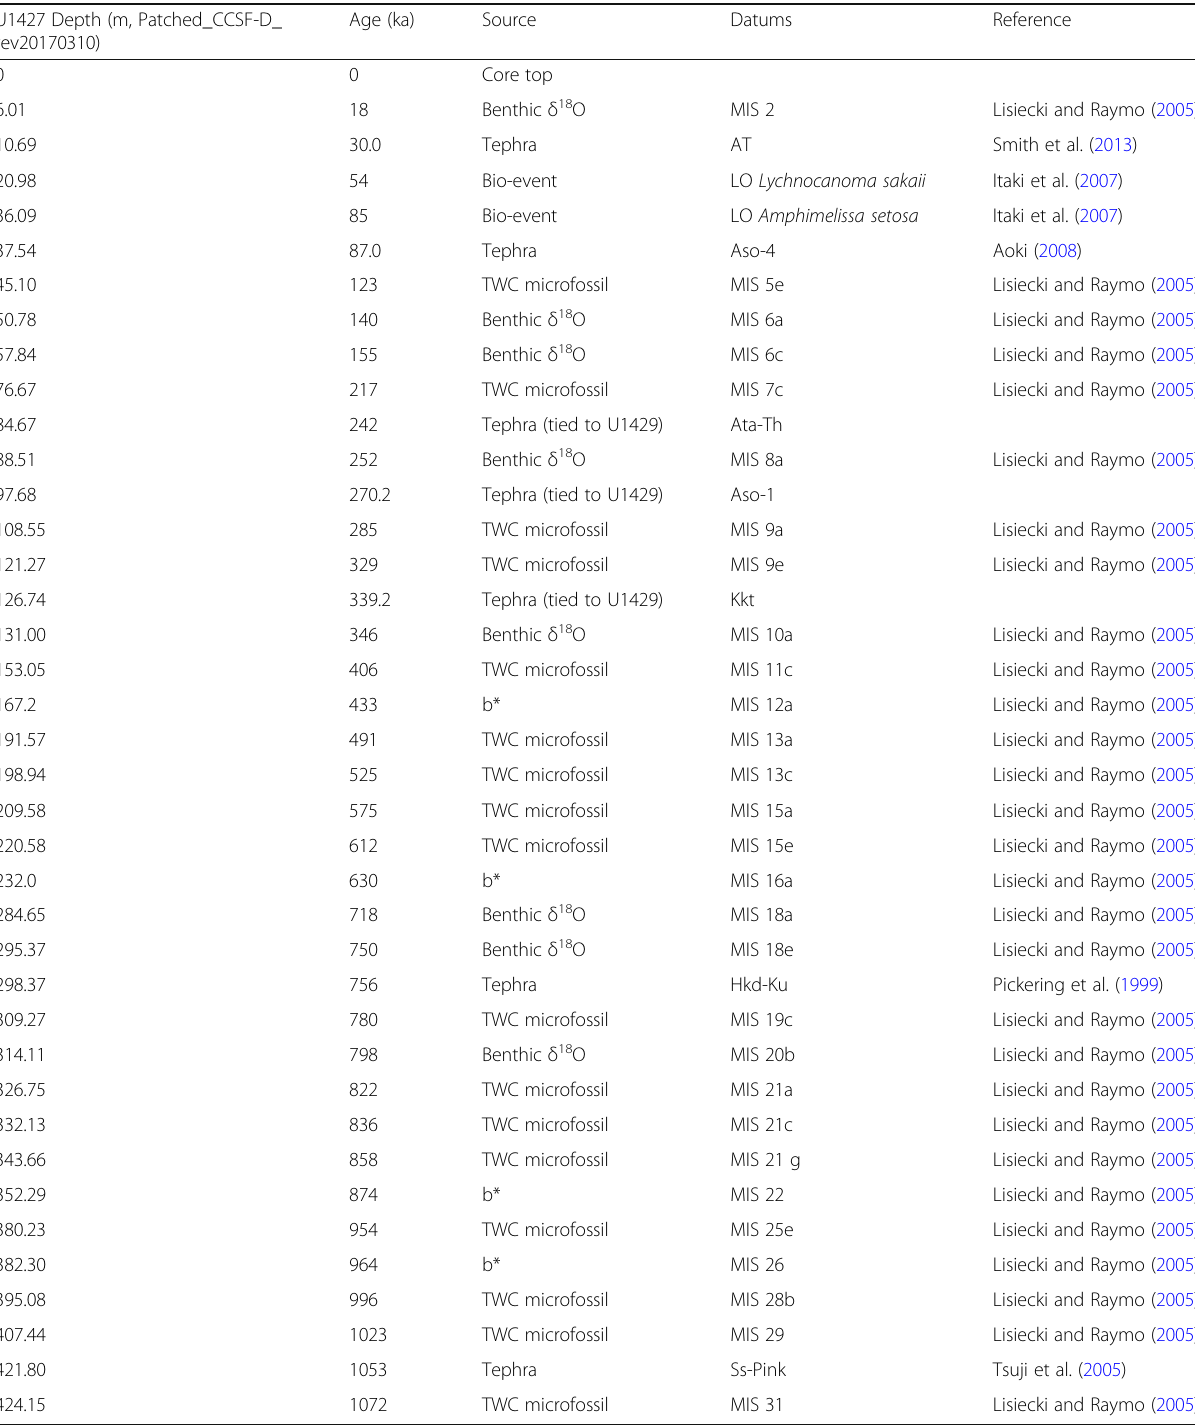
Table 4 Age control points for the succession at Site U1427 U1427 Depth (m, Patched_CCSF-D_